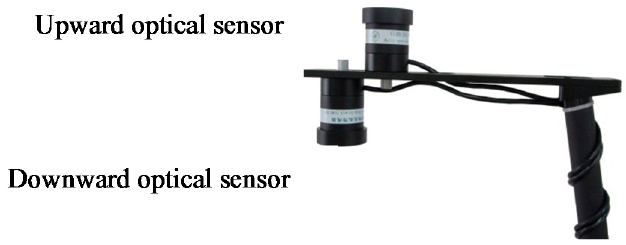
Figure 3. Multispectral sensors.